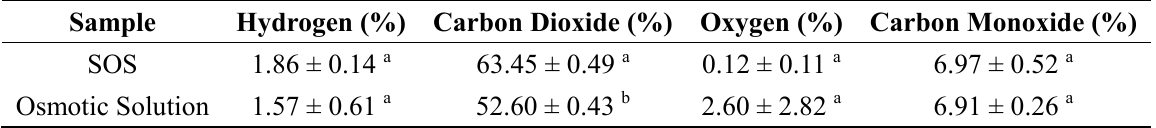
Table 5. Average (mean ± SD, replications = 3) gas composition of gaseous products generated during hydrothermal treatment (250 °C for 30 min) of OS and SOS generated from blueberry